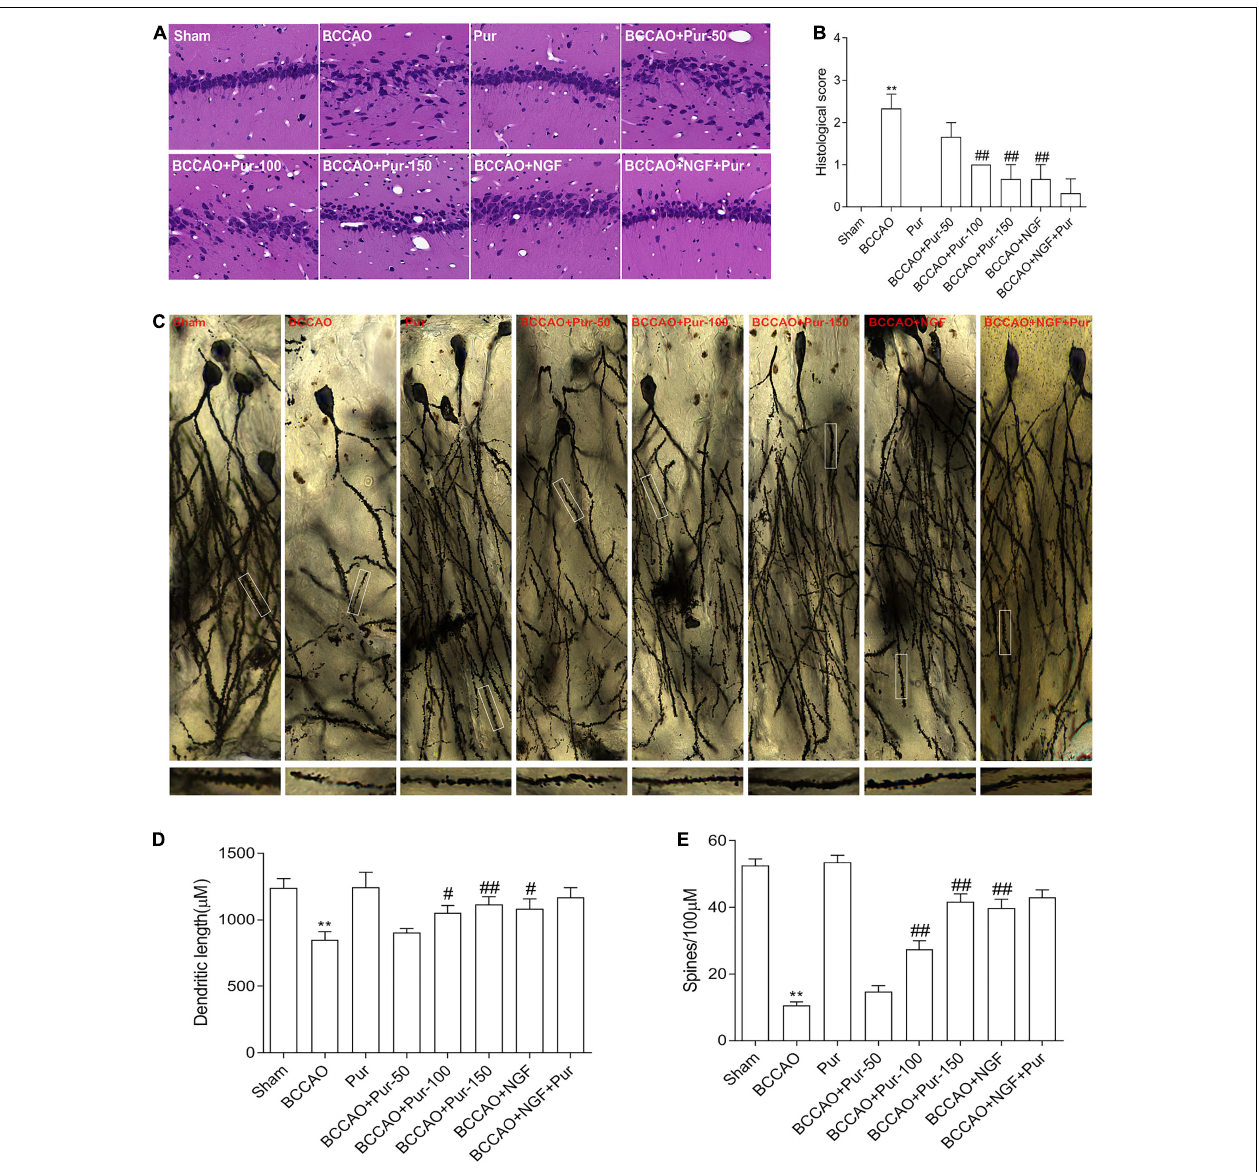
FIGURE 3 | Pur’s effects on morphological alterations and dendrites in the hippocampus of BCCAO rats (H&E staining and Golgi-Cox staining). (A) HE staining in groups, Representative micrographs are shown at × 200. (B) Histological score. (C) Golgi staining in groups. (D) Percentage of mushroom spines. (E) Number of spines. Values were mean ± SEM ( n = 6). ** P < 0.01 vs. Sham; # P < 0.05, ## P < 0.001 vs. BCCAO group.